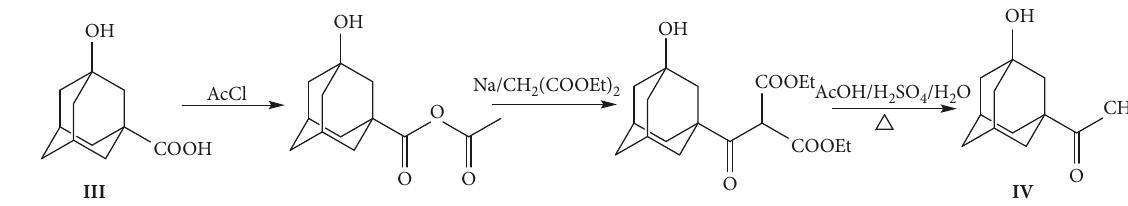
Figure 5: Improved one-pot method.